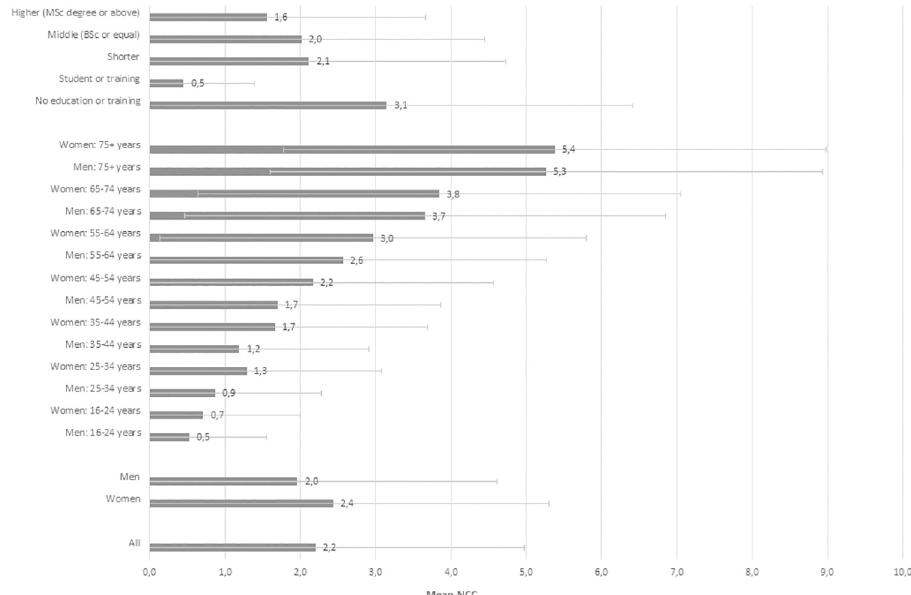
Fig 2. Mean NCC and one +/- standard deviation (SD)–for the entire population, sex, age groups and educational attainment.